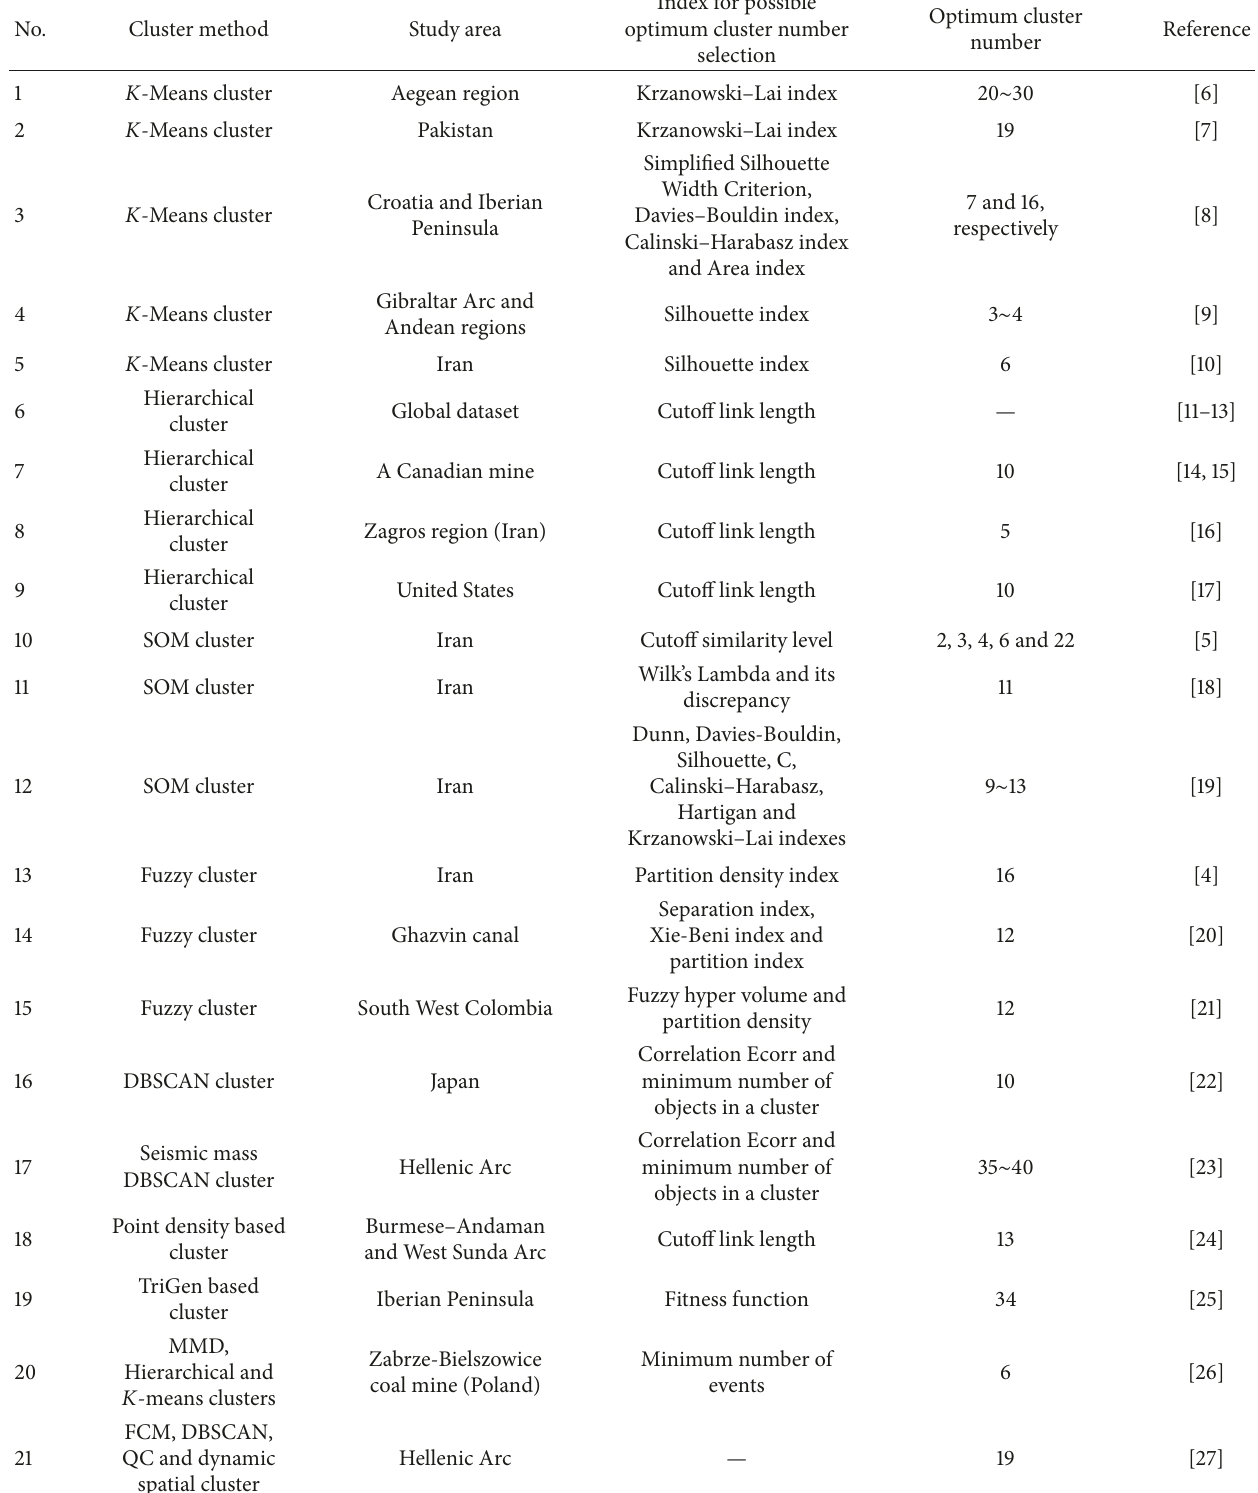
Table 1: Summary of typical seismicity partitioning